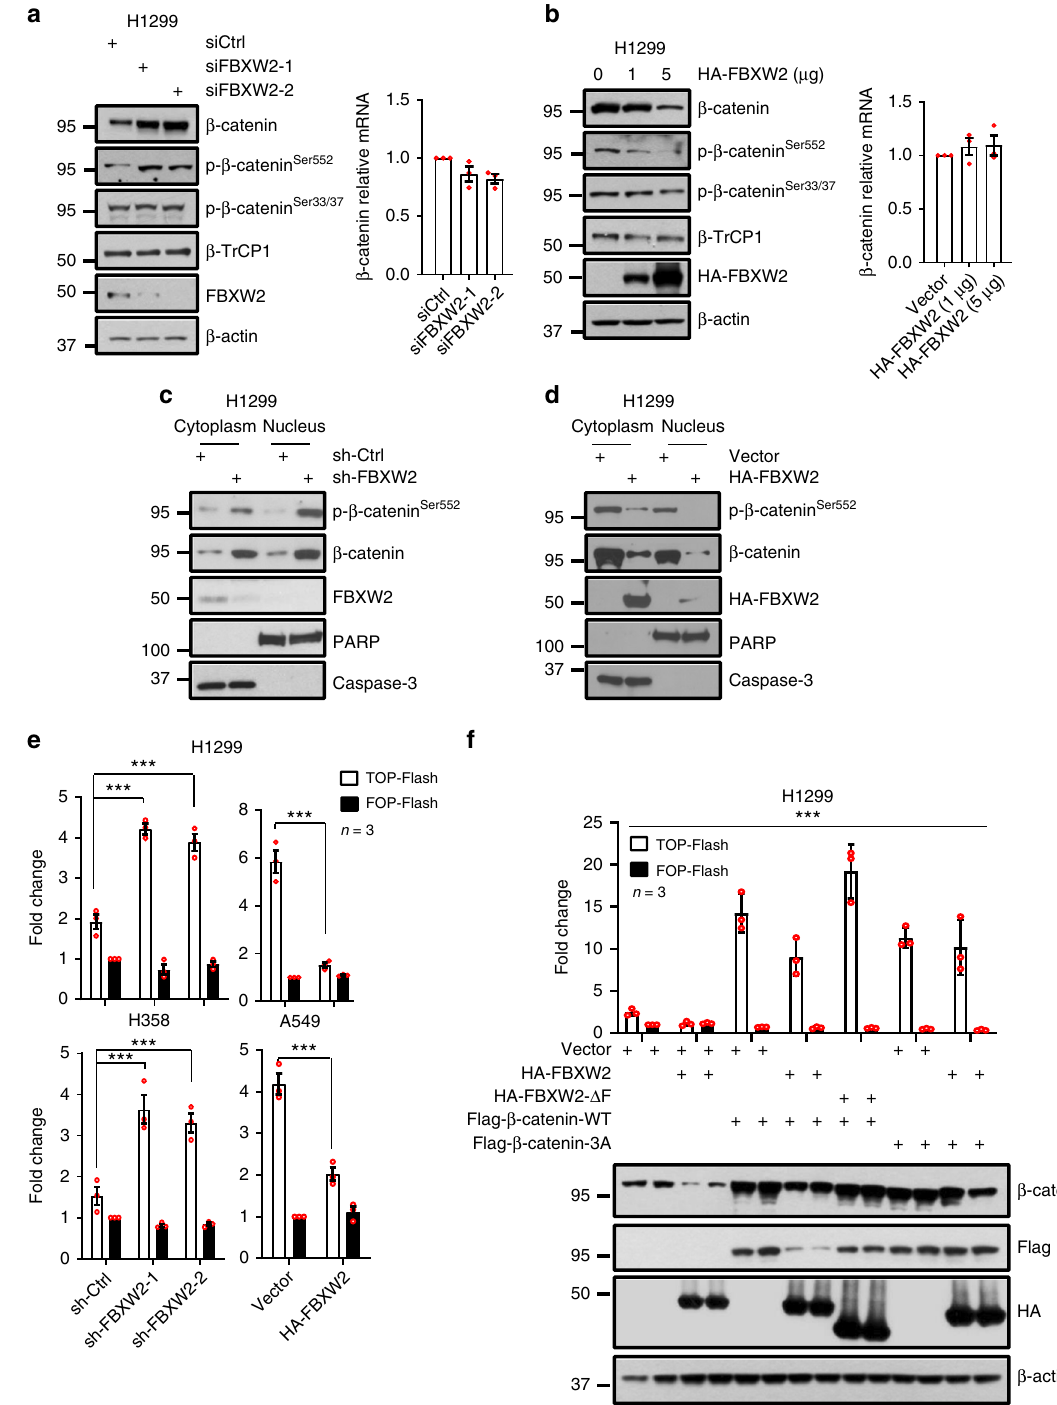
reduced them in a dose-dependent manner in various lung cancer catenin-Ser552. These results are consistent with our recent fi ndings that β -TrCP1 negatively regulated FBXW2 by promoting cell lines. However, the levels of phosphorylated β -catenin-Ser 33/37 and total β -catenin mRNA were not affected by FBXW2 manip- its ubiquitylation and degradation 4 . ulations (Fig. 2a, b and Supplementary Figure 2b, c). Thus, FBXW2-induced reduction of β -catenin protein levels is through a post-transcriptional mechanism in a manner independent of phosphorylation of β -catenin on Ser 33/37 sites. On the other hand, β -TrCP1 manipulations negatively regulated protein levels of endogenous total β -catenin, phosphorylated β -catenin-Ser33/37 as well as FBXW2, but positively regulated phosphorylated β - NATURE COMMUNICATIONS| (2019) 10:1382